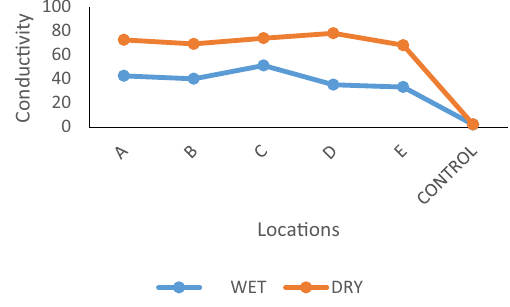
Fig. 4 The chart of conductivity variation across the